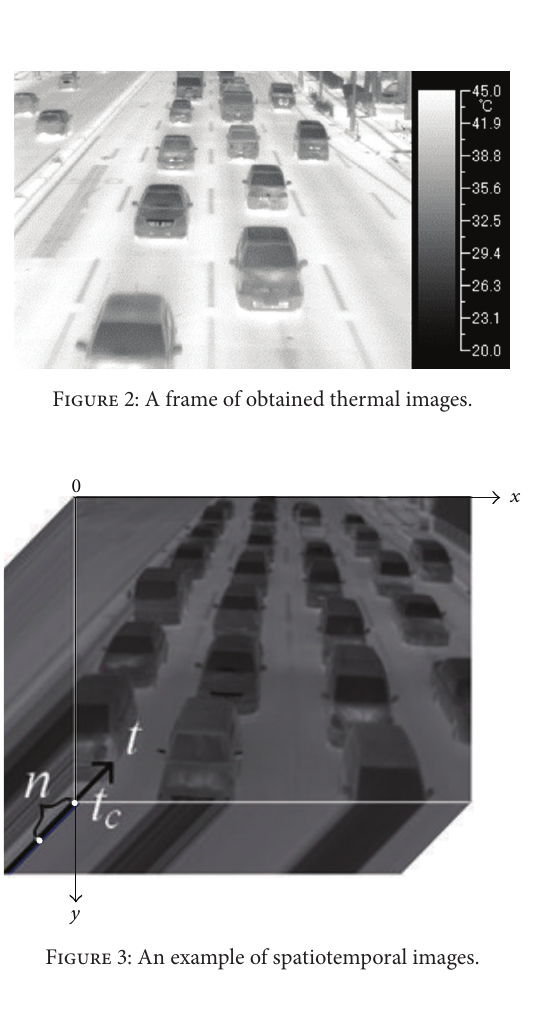
a snow and thick fog condition in a winter cold day.